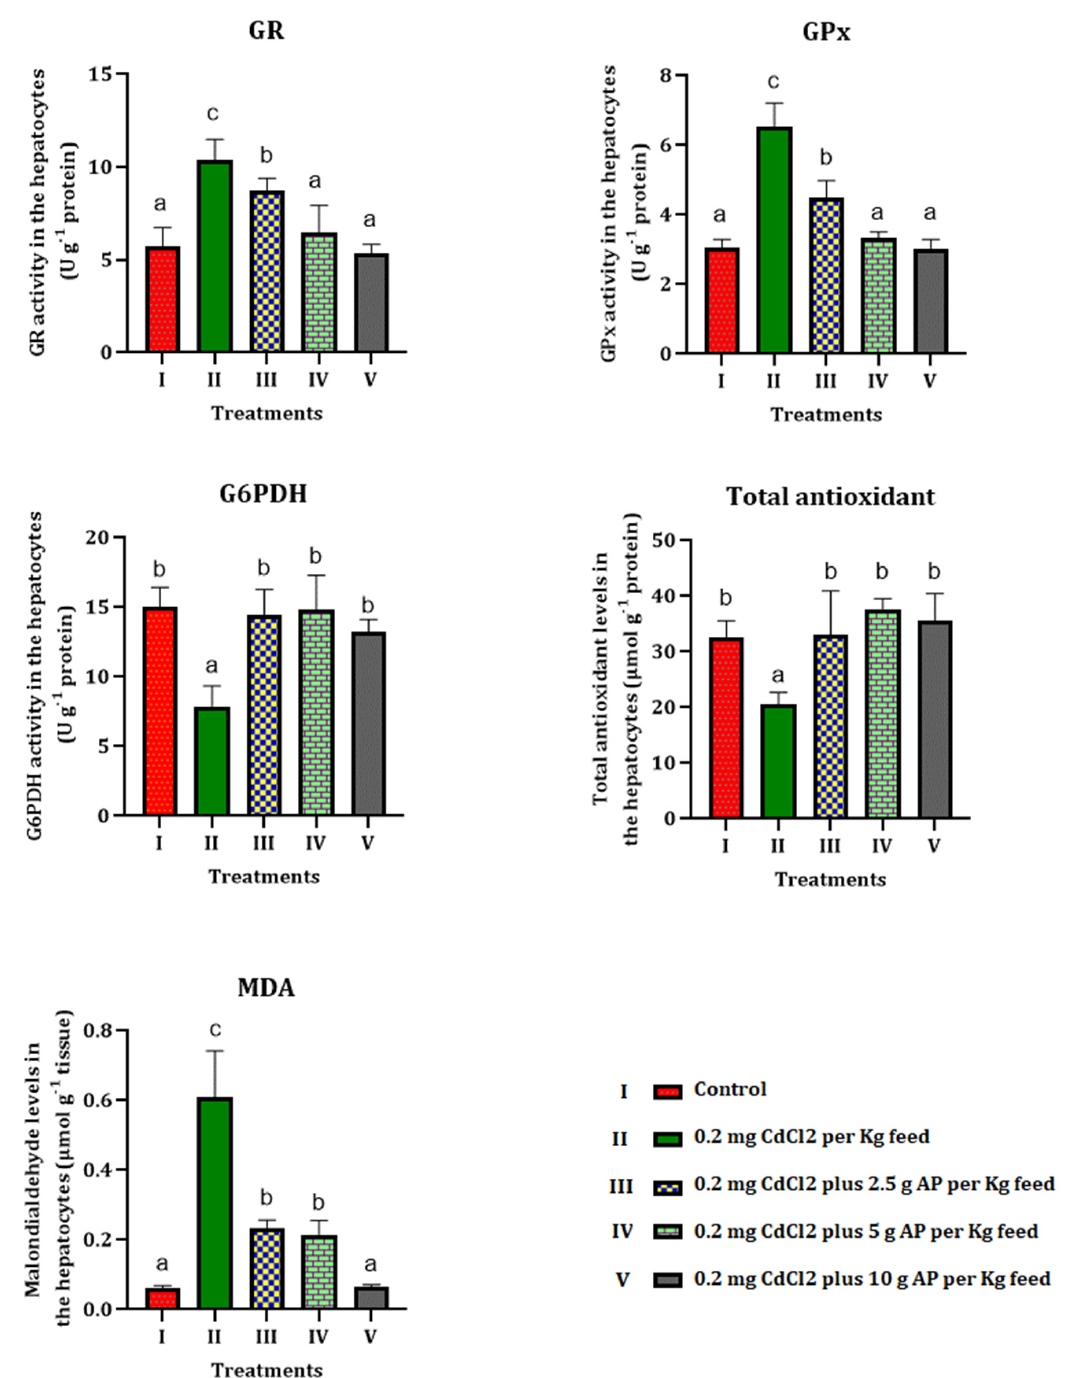
Figure 1. Results on tissue antioxidant values and oxidative stress markers. Different letters show significant changes in values ( p < 0.05) and ( p < 0.01), and the same letter shows there was no significant difference between the experimental groups. One-way ANOVA was used to analyze the data. Duncan’s test was used for the comparison, with confidence levels of 95% ( p = 0.05) and 99% ( p =